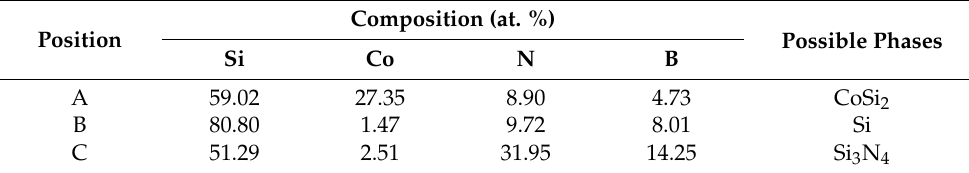
Figure 3. XRD patterns of the fractured surface of the reference welded joint. Table 1. The EDS results of the points signed in Figure 2b.